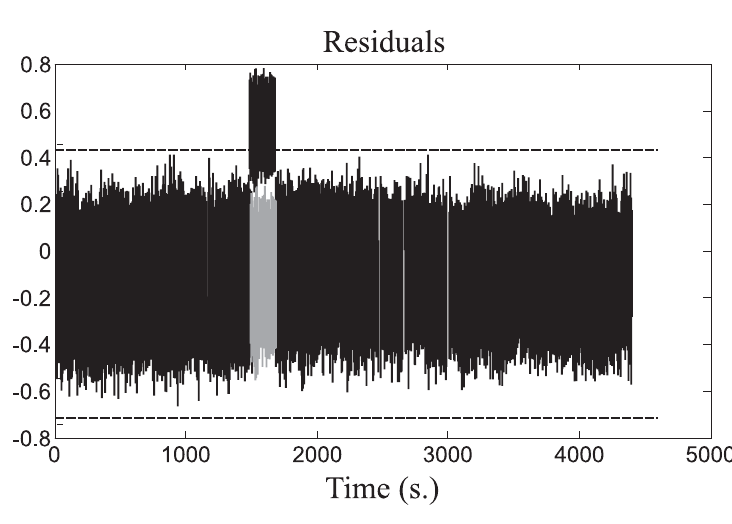
( t ) for the fault Case 4 O i